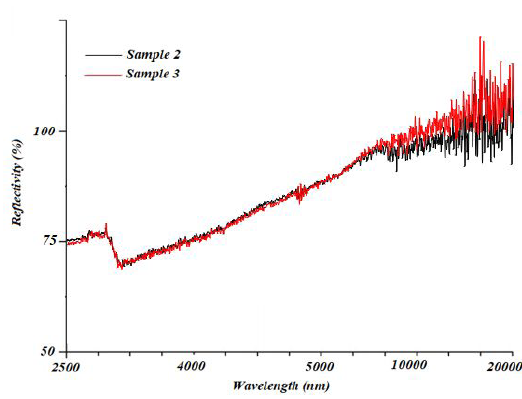
Figure 3. Reflectivity of the evaluated samples.